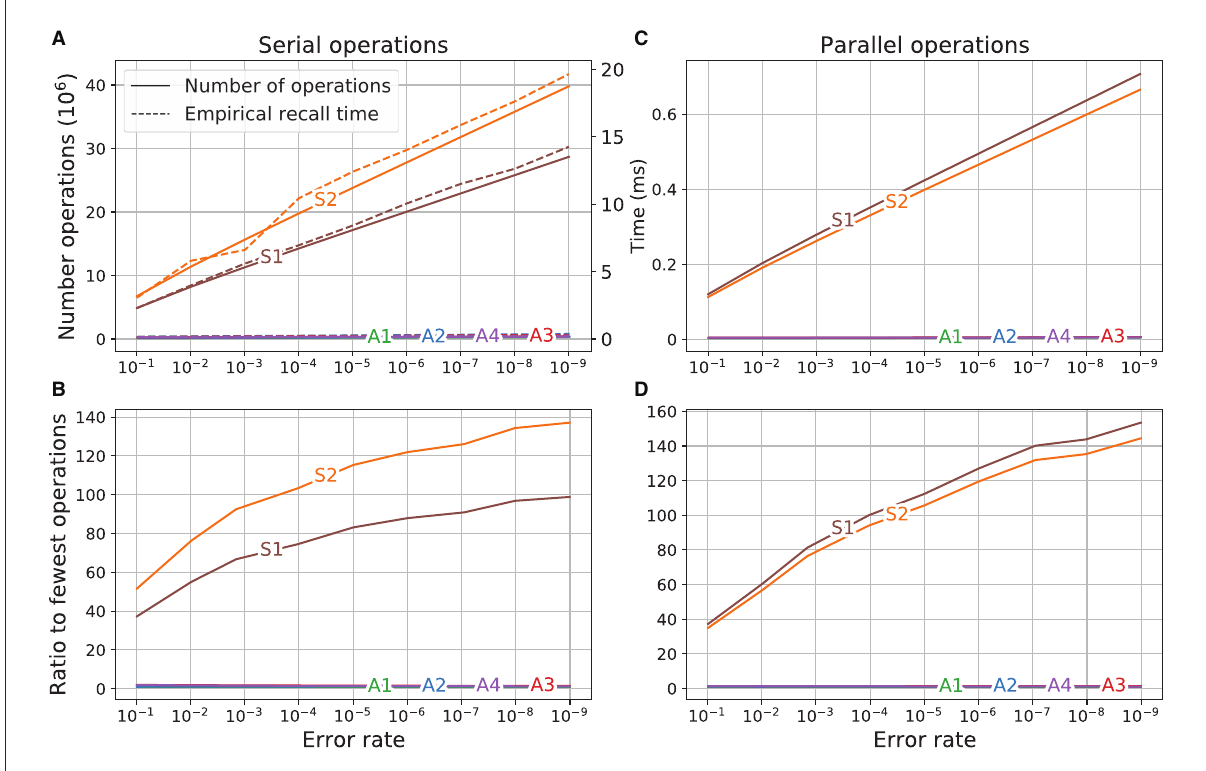
FIGURE6 Comparison of operations and run time. Left: operations are serial; Right: operations are parallel. (A) Number of operations (solid line, left axis) and empirical time (dashed line, right axis). (B) Ratio of number of operations to operations of variant using the fewest operations. (C) Number of parallel operations. (D) Ratio of number of parallel operations to variant using fewest